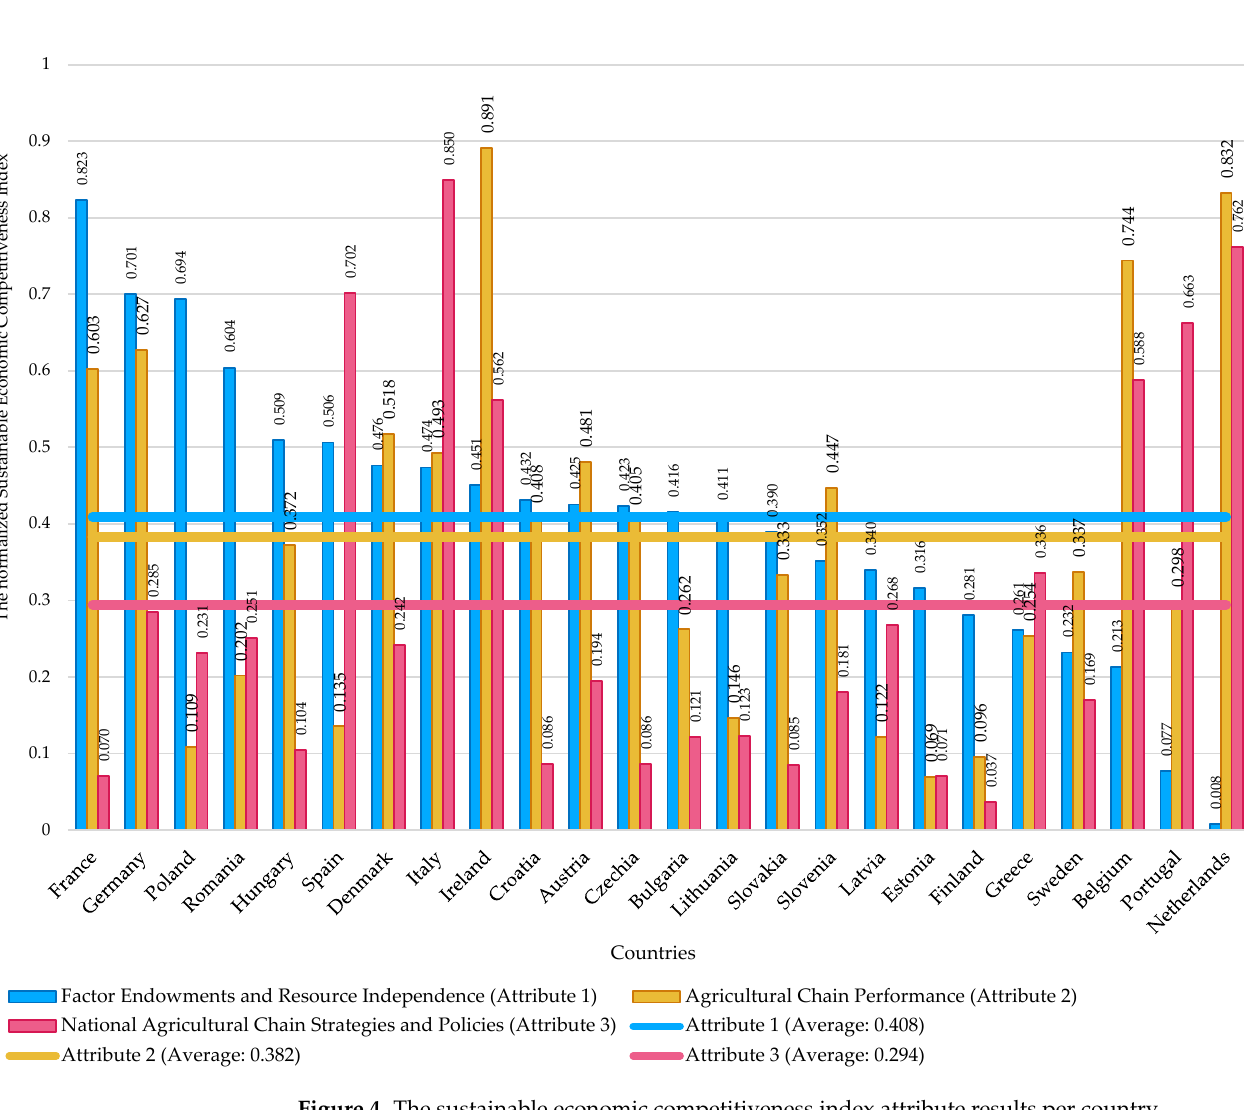
Figure 4. The sustainable economic competitiveness index attribute results per country.